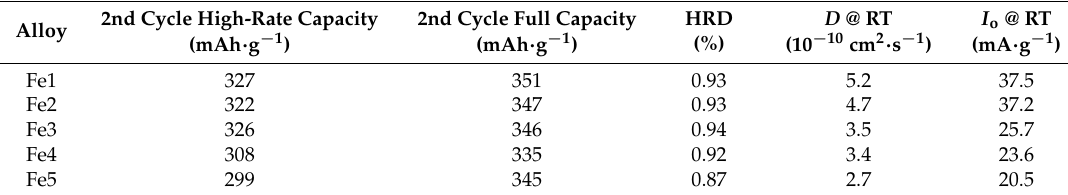
Figure 8. Activation characteristics over the first 13 cycles demonstrating ( a ) full discharge capacity with the lowest discharge current (8 mA · g –1 ); and ( b ) high-rate dischargeability (HRD) for alloys Fe1–Fe5. Table 5. Summary of electrochemical properties: capacity, rate, bulk diffusion coefficient ( D ), and surface exchange current ( I o ). RT stands for room temperature.